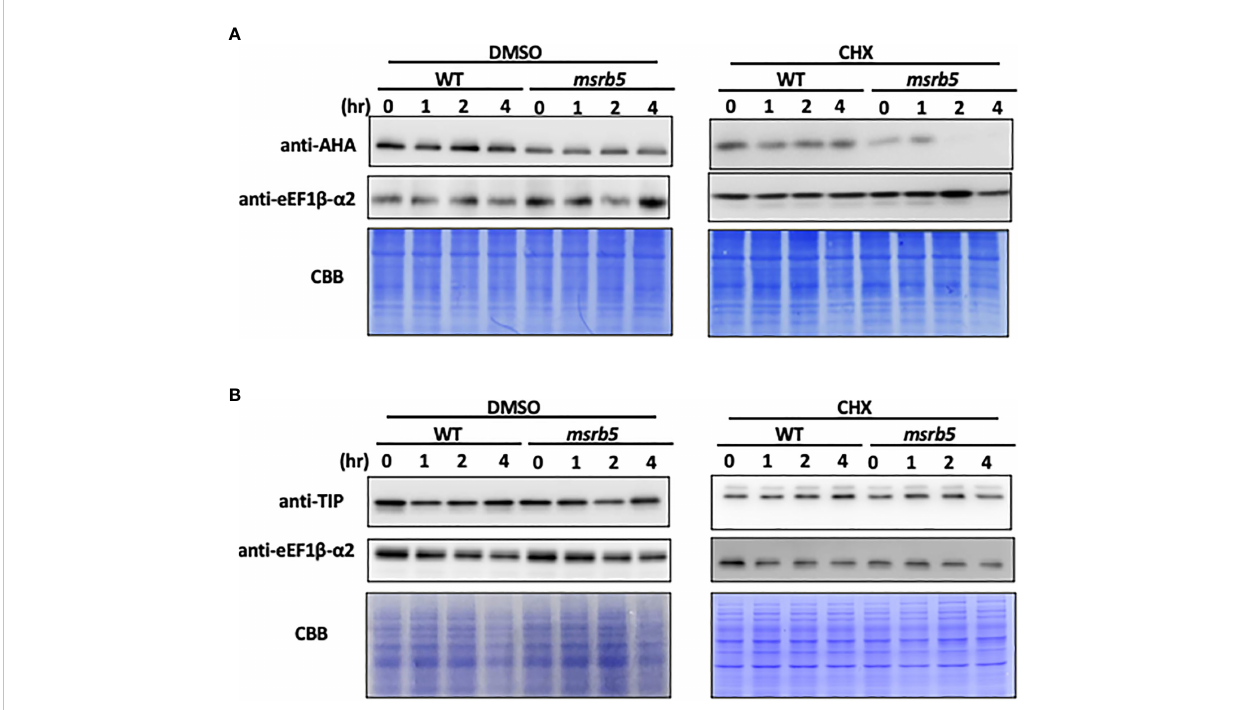
FIGURE 5 AHA but not TIP was unstable in msrb5. (A) C0 in 1/2 MS medium was transferred to 150 mM NaCl medium and sampled at various times. Total protein of root tissues was extracted and analyzed for the expression level of AHAs and TIPs. (A, B) Immunoblotting of AHA and TIP1; 2. Ten-day-old 1301 and msrb5 seedlings were pre-treated with 150 mM NaCl for 1 h followed by treatment with 0.5 mM cycloheximide for 0 to 4 h. The expression of AHAs and TIPs was detected using H+ATPase and TIP antibody, respectively. The expression of eEF1 b - a 2 were used as the internal control and detected using eEF1 b - a 2 antibody. Protein stained with CBB was used as a loading control. Twelve percent (%) SDS-PAGE was used to detect the expression of AHAs and TIPs.